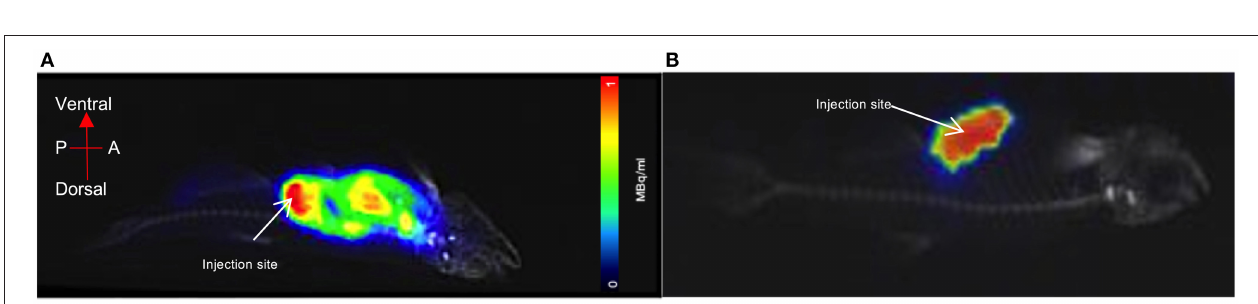
FIGURE 4 | Axial, coronal, and sagittal PET/CT image acquisition of the 3D printed zebrafish model post-injection of 0.05 MBq of [ 18 F]FDG. (A) CT image displays the CT contrast (white line) withing the model’s vascular system. (B) PET image reveals [ 18 F]FDG (coloured line) within the model’s vascular system. (C) Fused PET/CT confirms CT contrast and [ 18 F]FDG are within the model’s vascular system.